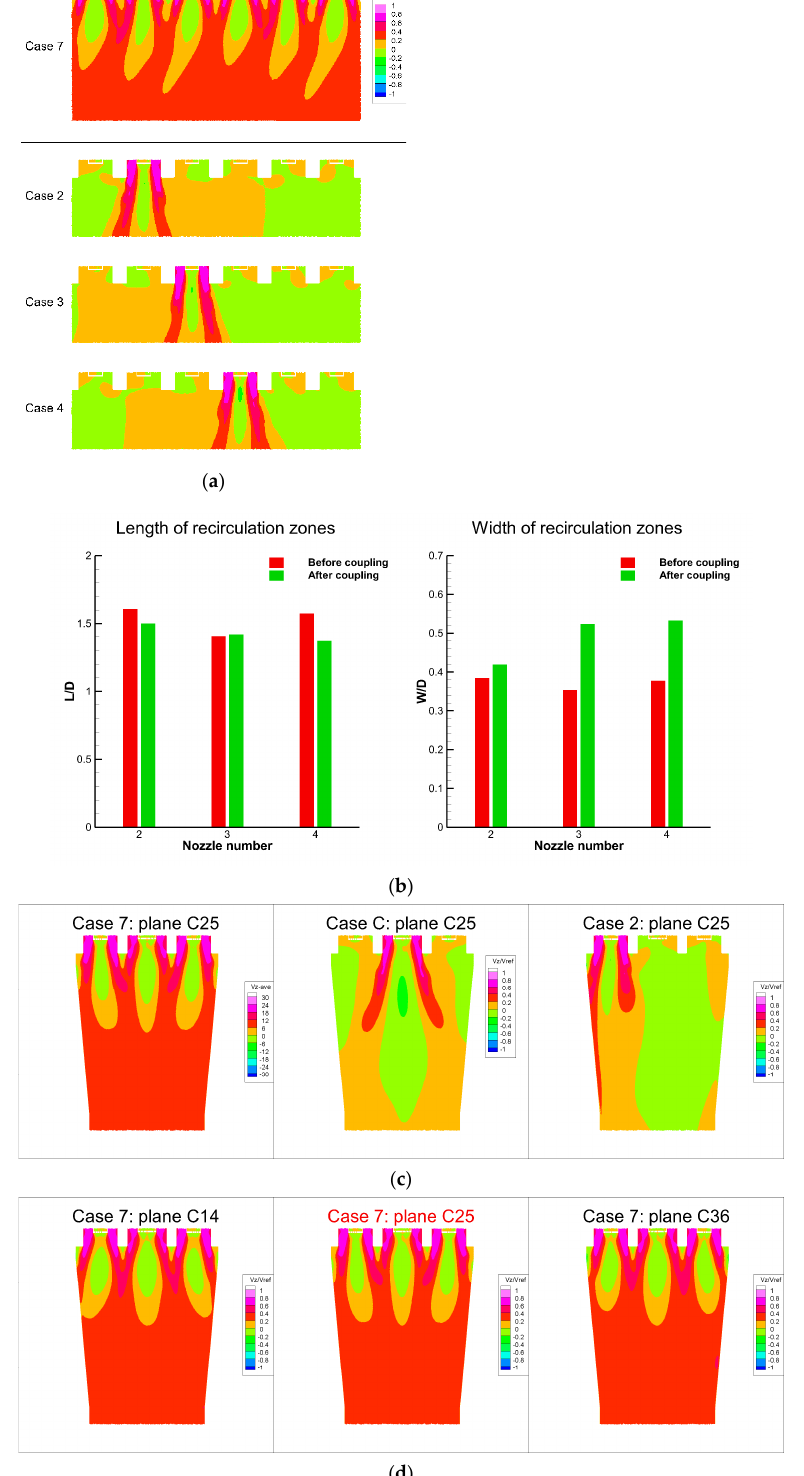
Figure 18. Recirculation zone information. ( a ) V z on Iso-surface R/D = 1.6 in different cases; ( b ) Length and width of nozzle 2, 3 and 4; ( c ) V z on plane C25 for different cases; ( d ) V z on different planes in Case 7.